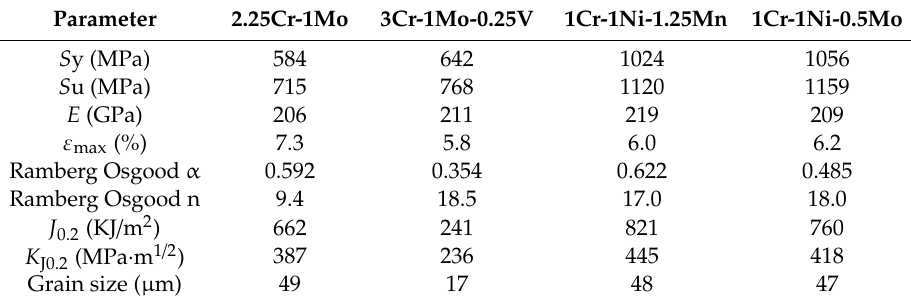
Table 1. Main properties of the steels employed. Figure 7. Microstructure of the 1Cr-1Ni-1.25Mn ( left ) and 1Cr-1Ni-0.5Mo ( right ).